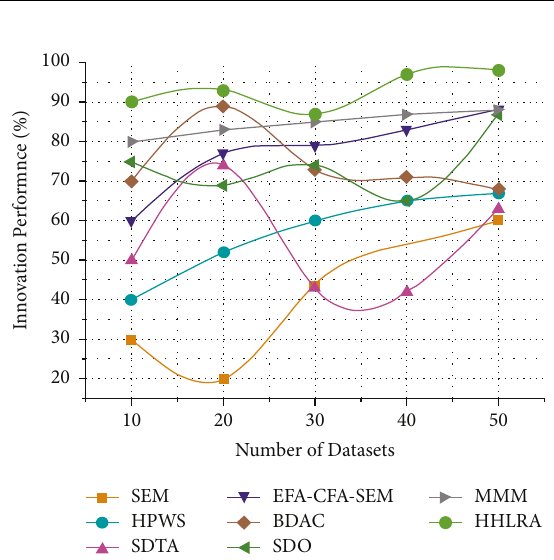
Figure 4: Innovation performance.